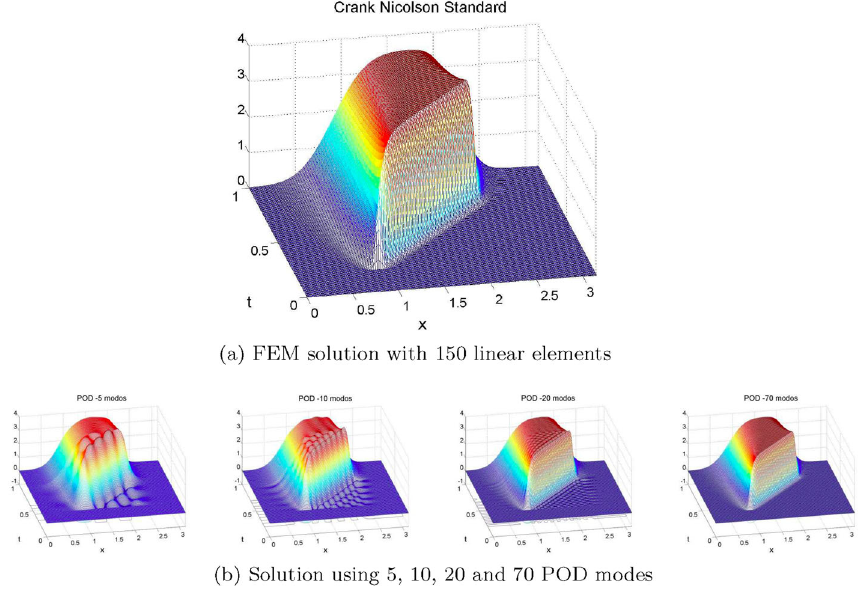
Fig. 6 The Idelsohn’s benchmark. Time–space solutions highlighting the drawbacks of global POD